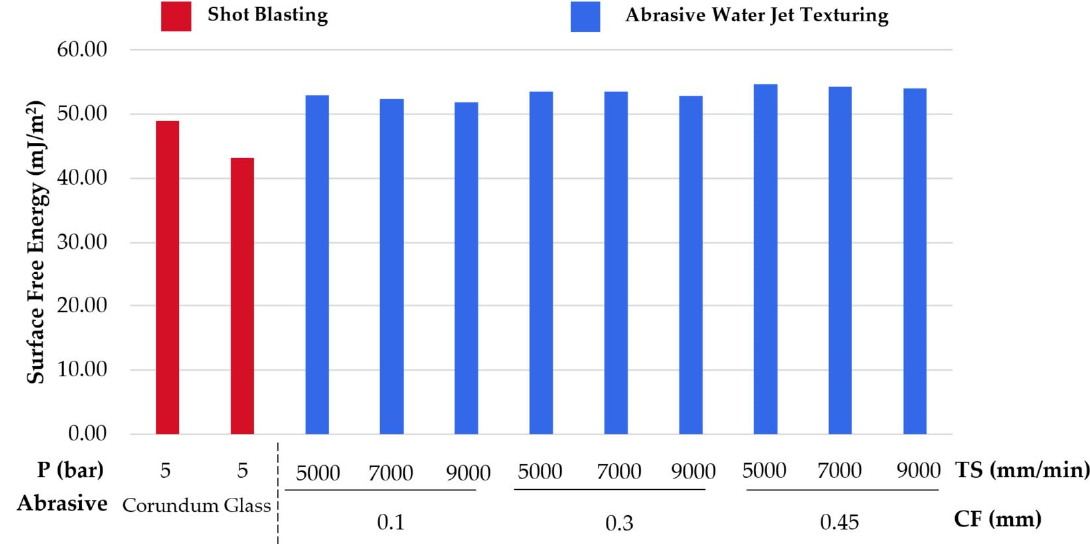
Figure 10. Surface free energy values for water jet texturing tests.